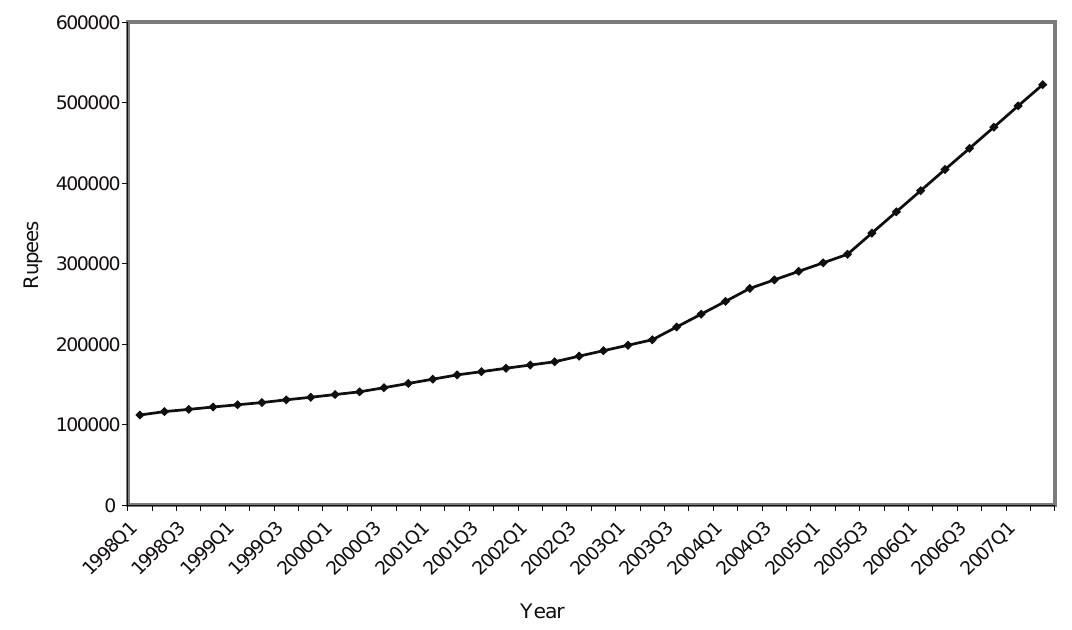
Figure 5. Gross domestic fixed capital